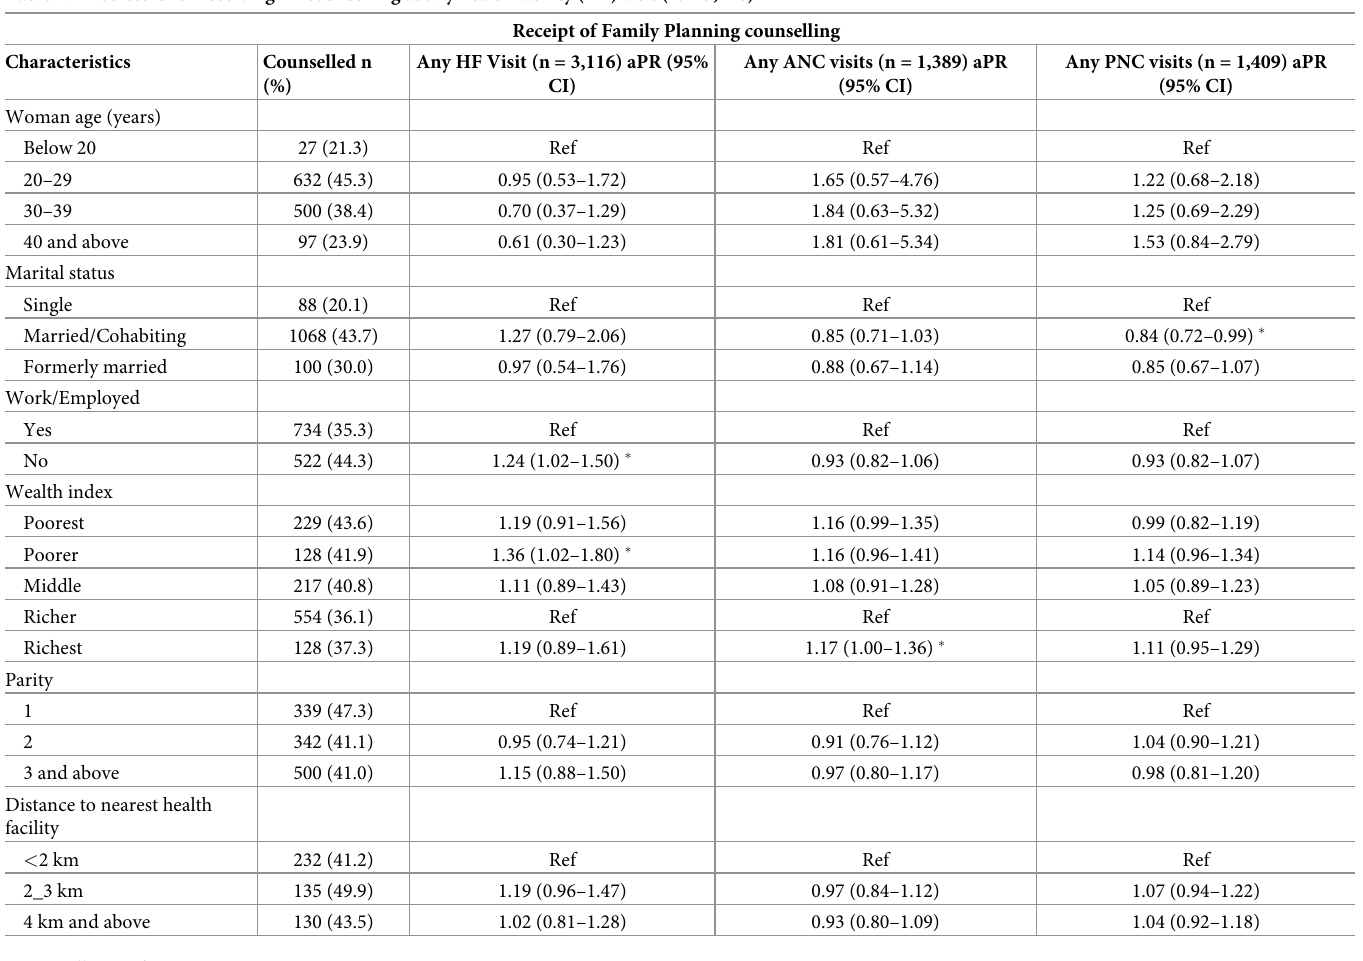
Table 2. Predictors for receiving FP counselling at any health facility (HF) visit (N =